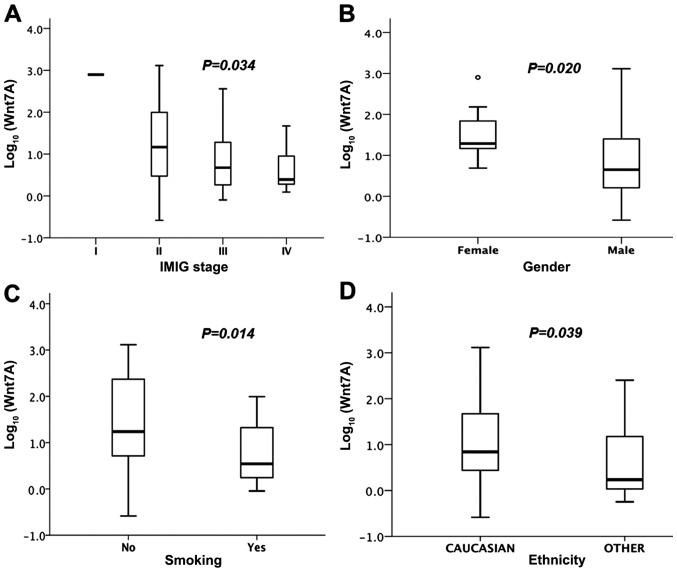
Wnt7A expression logarithm according to clinicopathological factors. (A) IMIG stage (I, II, III, IV), (B) gender, (C) smoking status and (D) ethnicity (Caucasian vs. other ethnicities). P-values were calculated by ANOVA in A and by 2-sided exact test in B–D, respectively.